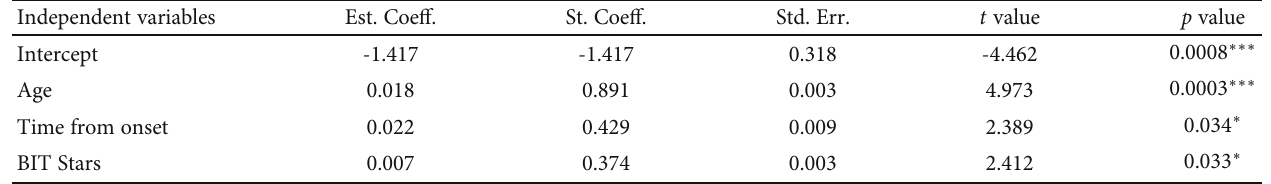
Table 3: Signi fi cant regression model for the subgroup of right brain damage patients. Independent variables